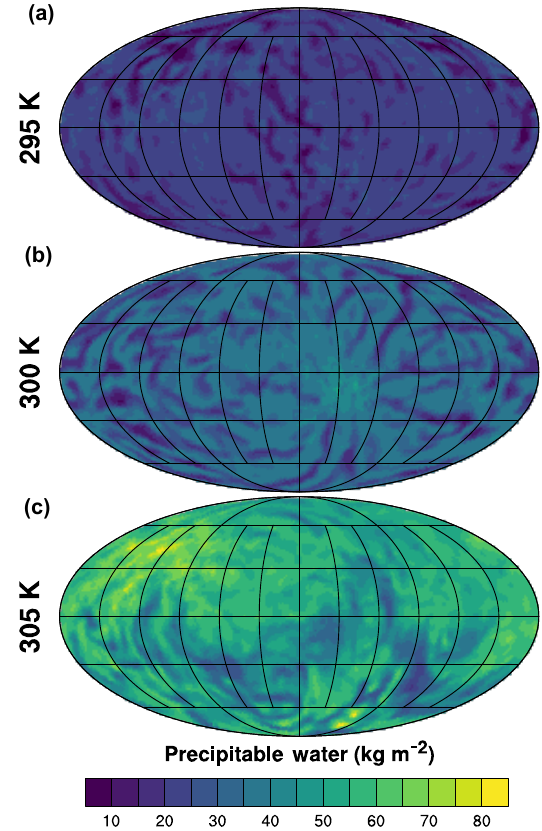
Figure 10. Hourly-averaged water vapor path from the last day (day 1095) of the three CAM simulations at T s = 295K (a) , T s = 300K (b) , and T s = 305K (c)